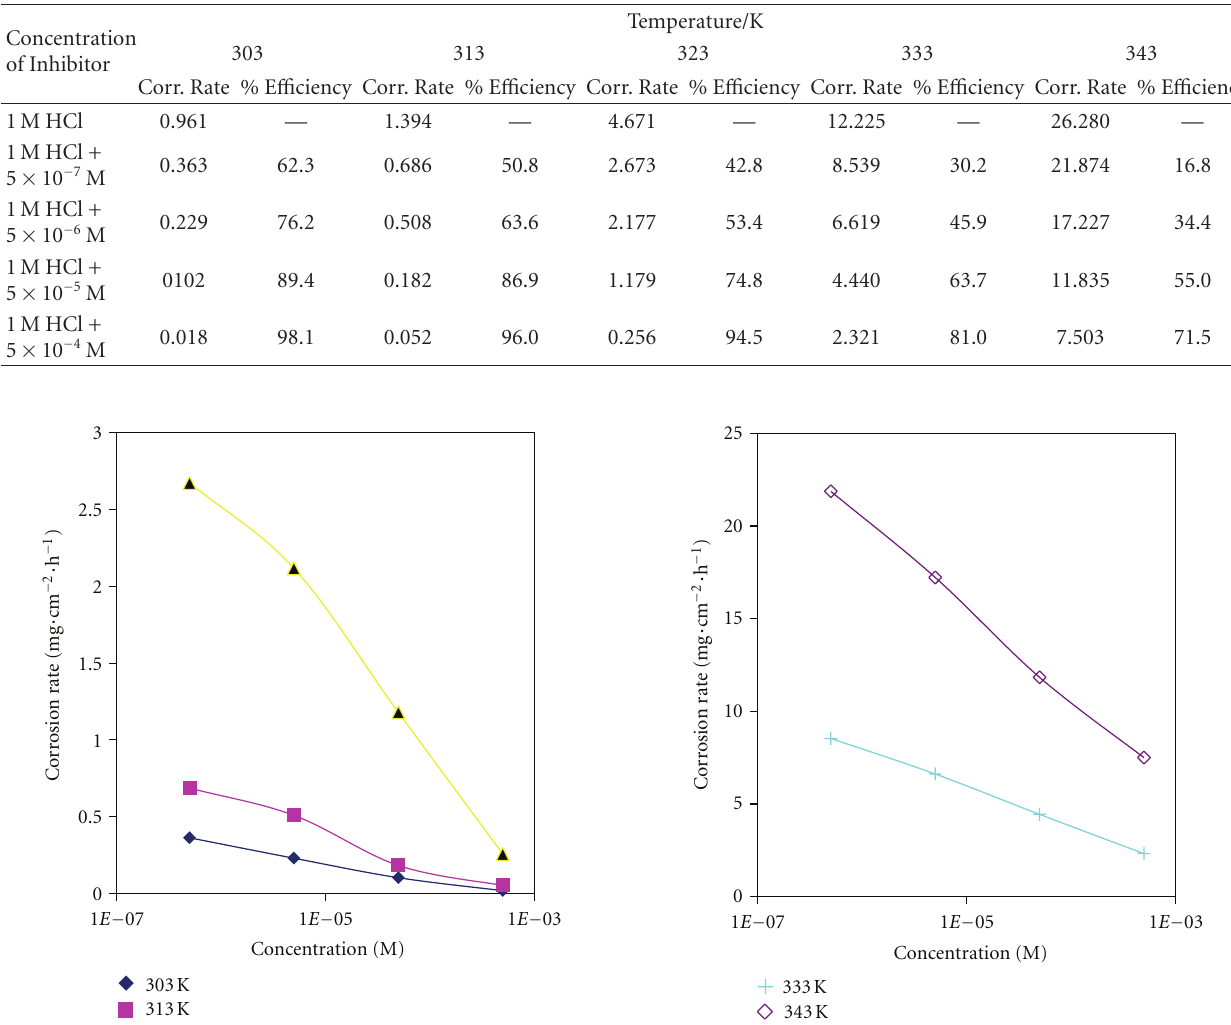
Table 2: E ff ect of concentration of 3-Benzoylmethyl benzimidazolium hexafluoroantimonate (BMBI) on the corrosion rate (mg · cm − 2 · h − 1 ) and percentage e ffi ciency of mild steel in 1.0 M HCl at various temperatures.